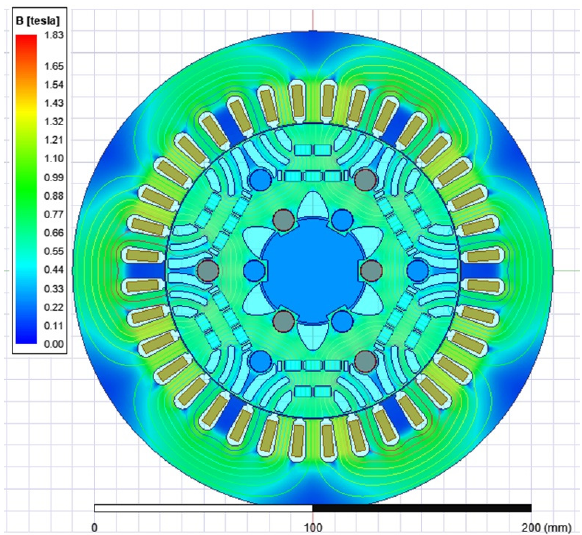
Figure 5. FEM analysis model of the machine.